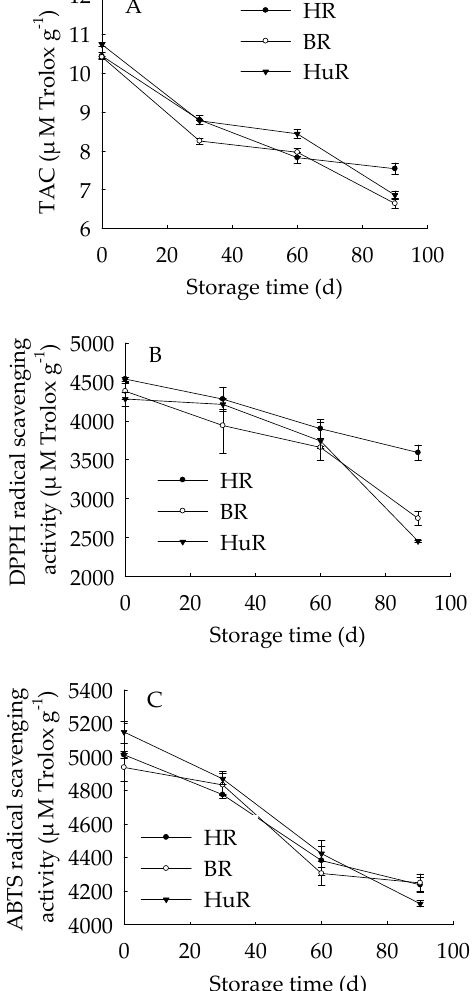
Figure 1. Changes in total antioxidant capacity (TAC) ( A ), DPPH radical scavenging activity ( B ) and ABTS radical scavenging activity ( C ) in juice sacs of Hongroumiyou (HR), Bairoumiyou (BR) and Huangroumiyou (HuR) during postharvest storage. Vertical bars represent the standard error (SE) of the means of three replicate assays.